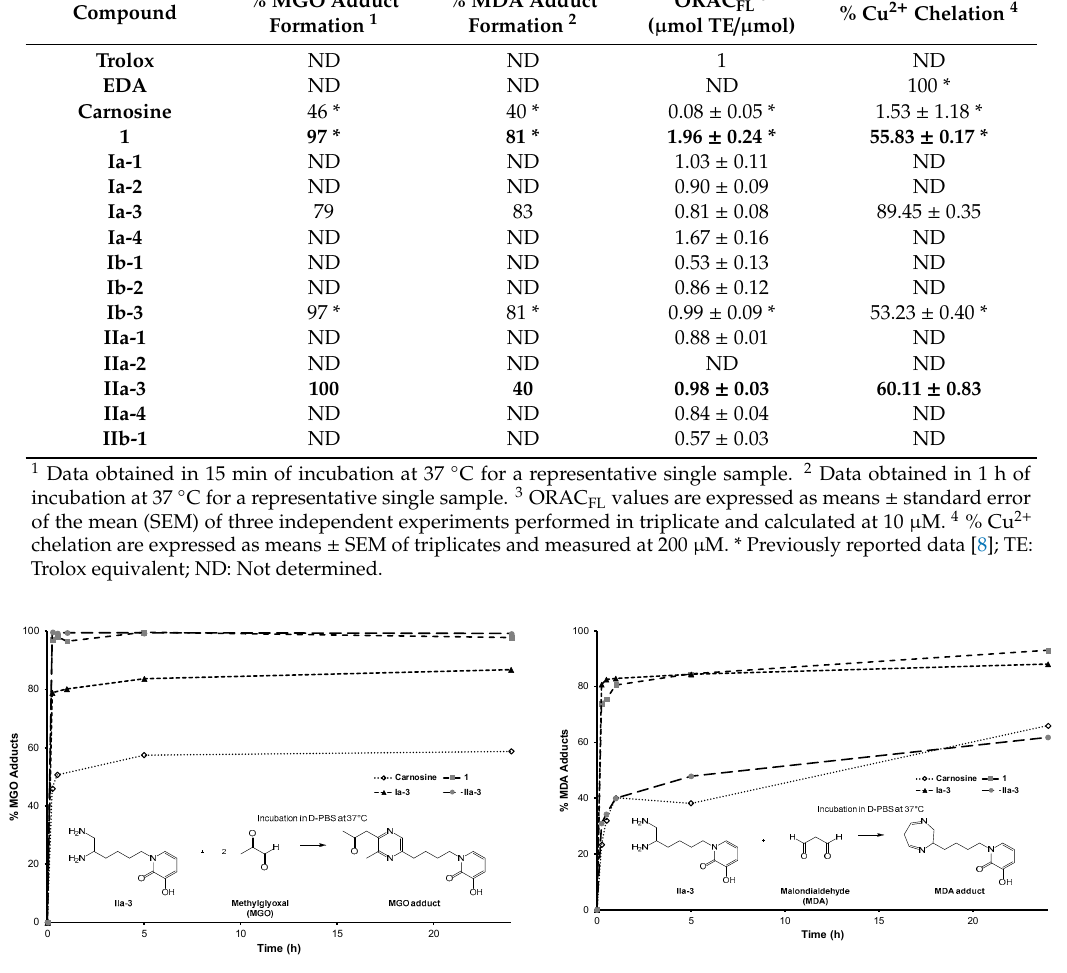
Table 3. Reactive carbonyl species (RCS) trapping, oxygen radical absorbance and Cu 2 + -chelating capacities of new HOPO-diamine hybrids in comparison with previous lead compound 1 and references. Compound